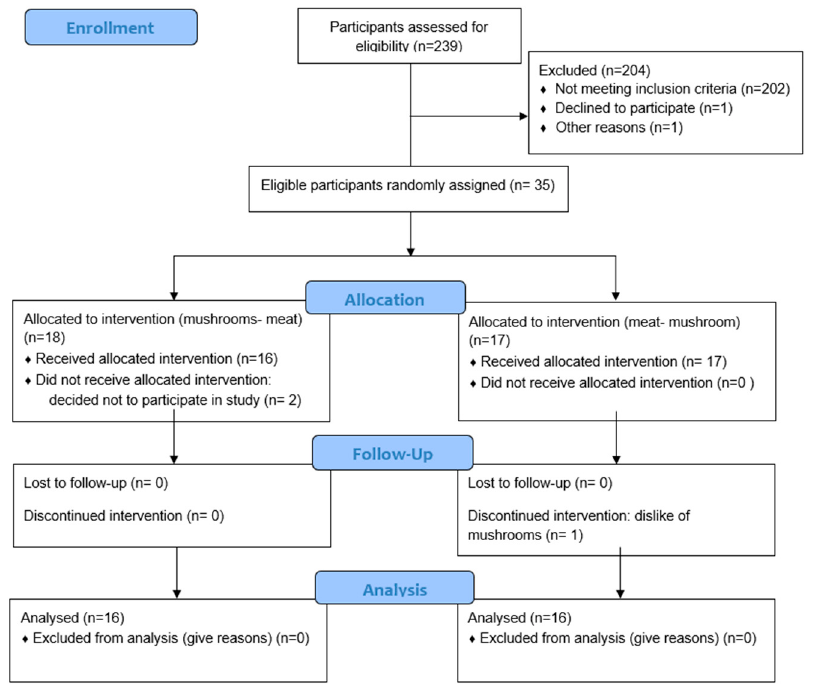
Figure 1. CONSORT flow diagram depicting the flow of participants through the intervention trial. CONSORT, Consolidated Standards of Reporting Trials. Table 1. Carbohydrate content of roasted A. bisporus mushrooms 1 .